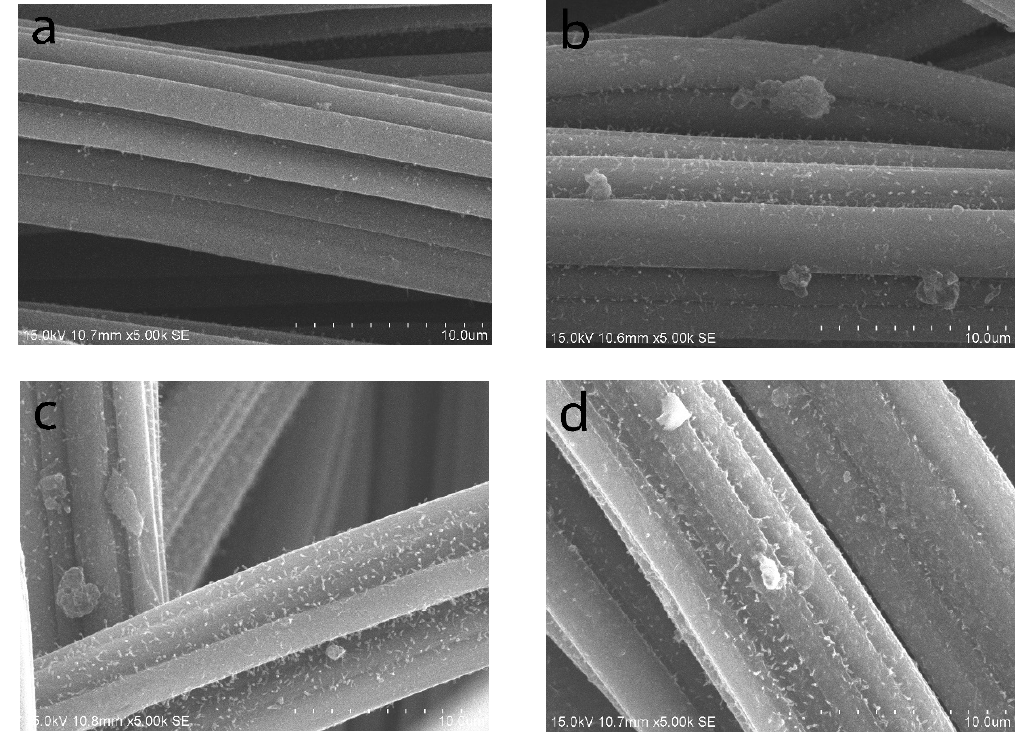
Figure 2. SEM images of a carbon cloth anode treated with different methods: ( a ) CC, ( b ) N_CC, ( c ) N_H_CC, and ( d ) F_CC.